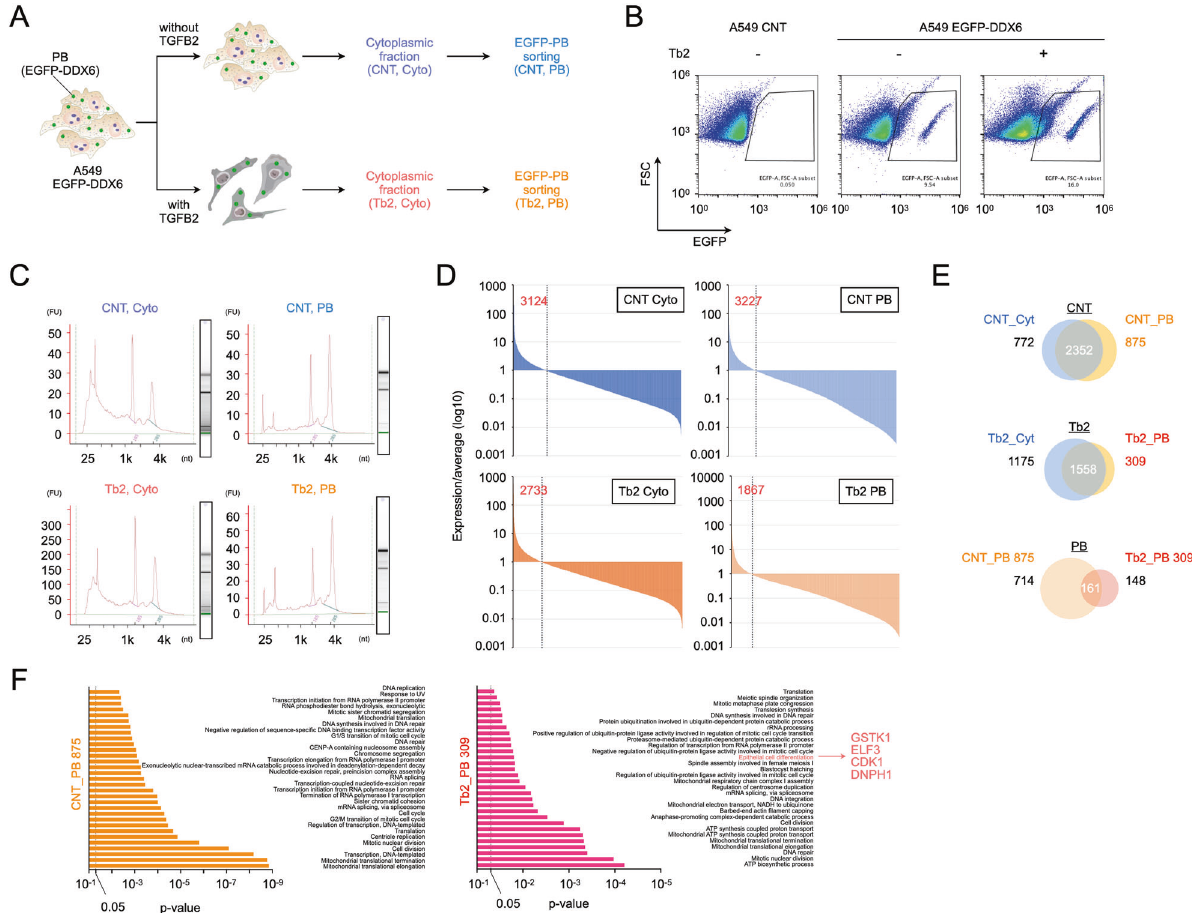
Fig. 5 Analysis of RNA molecules contained in PB using a fl uorescence-activated particle sorting. A The cells were A549 EGFP-DDX6, in which EGFP-DDX6 was expressed by pMXs retrovirus vector. Each cell was separated into cells with TGFB2 (Tb2) and without TGFB2 (CNT), and the cytoplasmic fraction (Cyto.) of each cell was collected, and RNA was collected. Additionally, EGFP- fl uorescent PBs (PB) were isolated from the cytoplasmic fraction by FACS. B Representative fi gure for PB sorting. C Quality check of RNA collected by PB sorting. The evaluation was done with an Agilent Bioanalyzer ( n = 1). D The exploration of gene groups whose gene expression levels in each condition are higher than the average statement value ( n = 1). The expression levels were quanti fi ed by fragments per kilobase of exon per million reads mapped (FPKM). E Venn diagram for each condition. F Gene Ontology analysis results using DAIVD for each